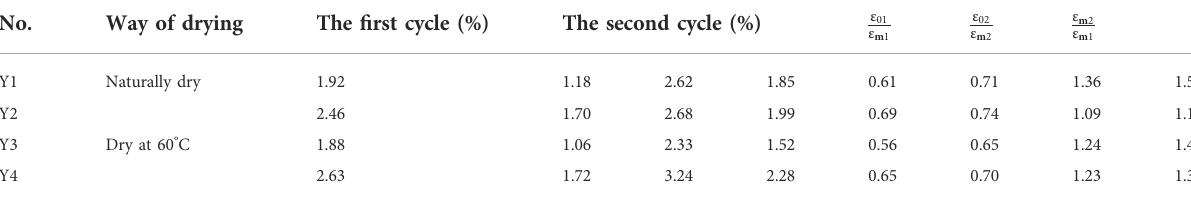
TABLE 3 Statistics of dry-wet deformation.